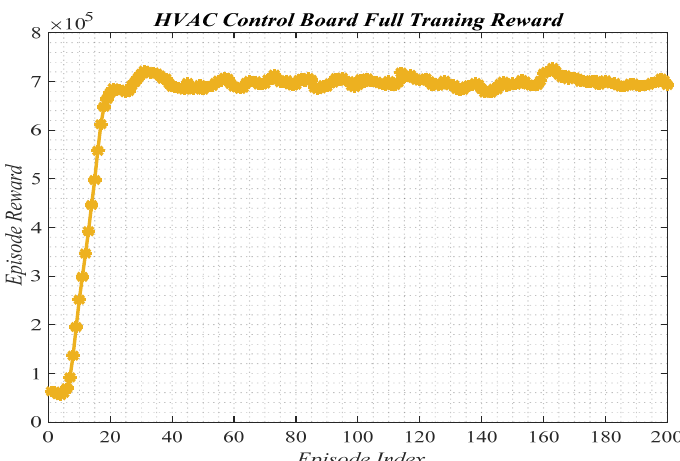
Figure 8. The trend of average reward in the HIL environment.